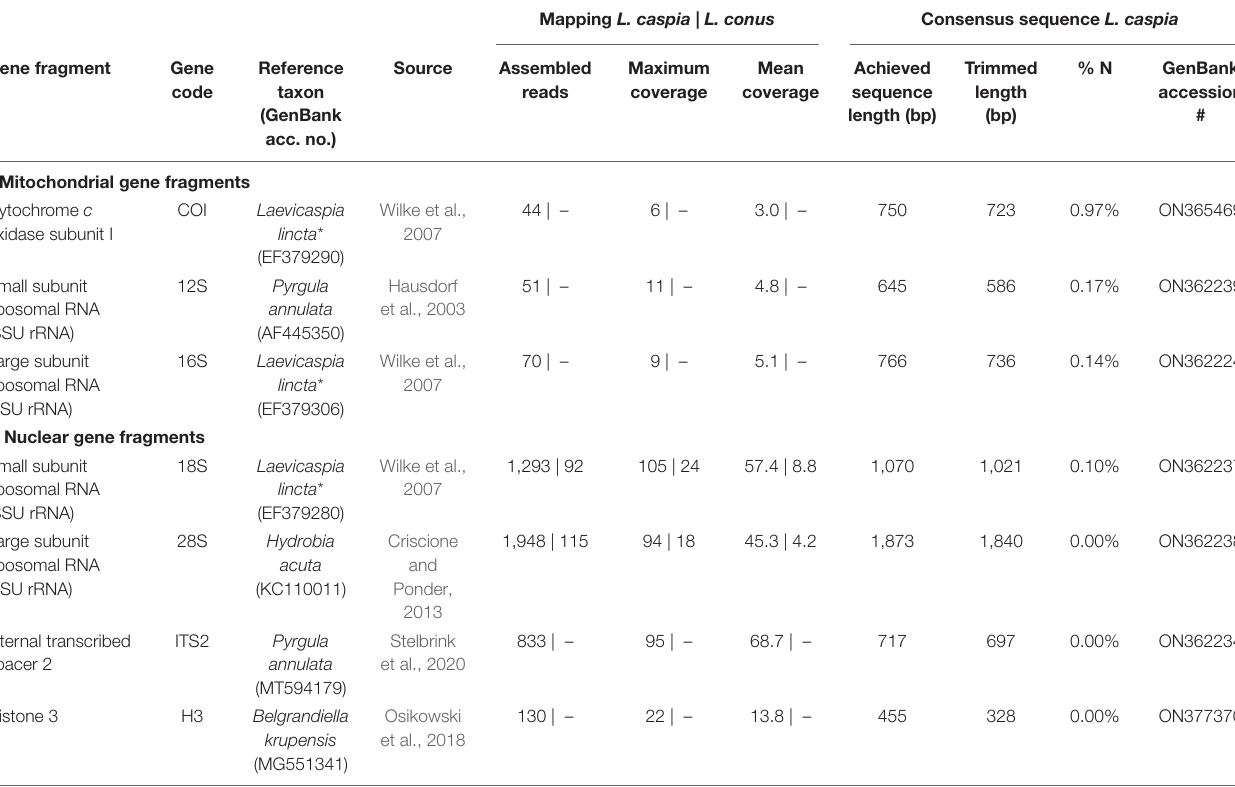
TABLE 2 | Overview of achieved gene fragments for Laevicaspia caspia and L. conus (for the latter, only the mapping results are shown). Mapping L. caspia | L.